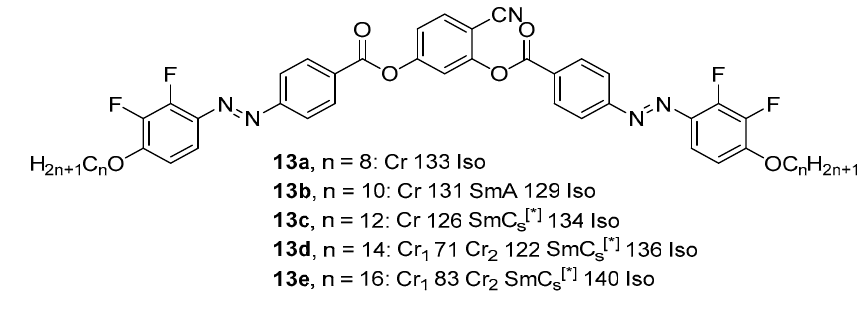
Figure 4. Textures of the chiral SmC s[ * ] phase of compound 13e at T = 127 °C, ( a , c ) between slightly uncrossed polarizers and ( b ) between crossed polarisers, exhibiting dark and bright domains